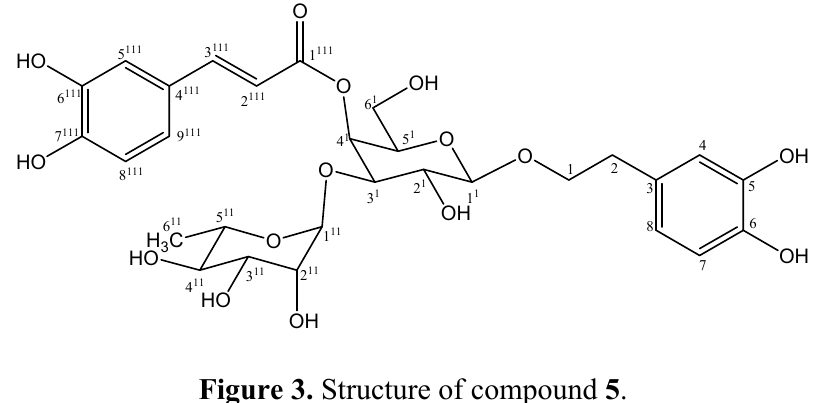
Figure 2. Structure of compound 3 .